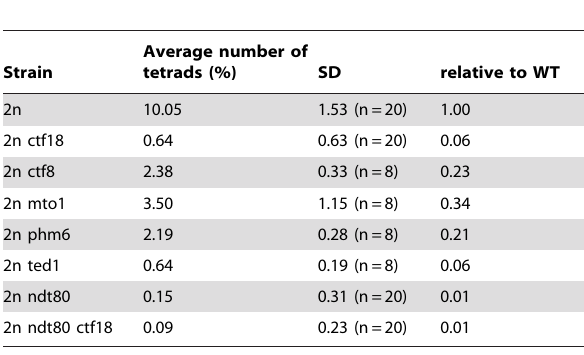
Table 3. Sporulation frequency in diploid cells lacking CTF18 , NDT80 , CTF8 , MTO1 , PHM6 and TED1 gene products.